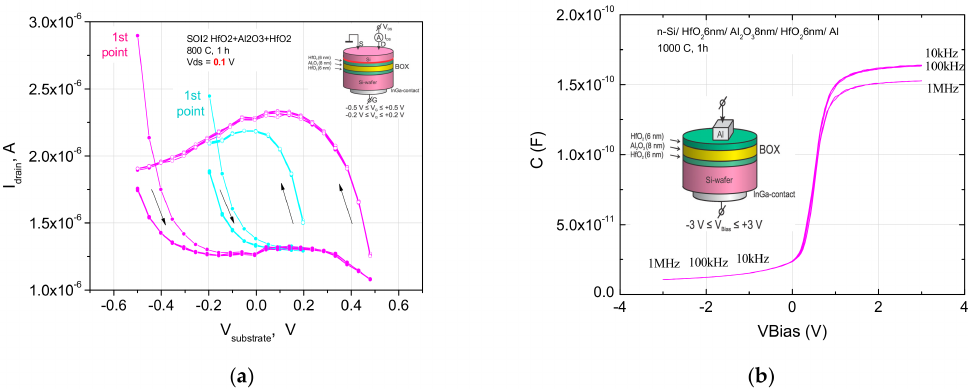
Figure 5. ( a ) Hysteresis behavior of the electron current in the transfer characteristics of n-SIS pseudo-MOSFETs with the 500 nm n-Si/20 nm HfO 2 6 nm/Al 2 O 3 8 nm/HfO 2 6 nm/n-Si substrate on the mesa structures with tungsten needle-shaped contacts (see inset) after the FA at 800 ◦ C for 1 h. Constant sweep rate 50 V/s in the two ranges of V g = − 0.2 + 0.2 V (cyan) and V g = − 0.5 + 0.5 V (magenta) is set for measurements with the starting (1st) point at V g = − 0.2 or − 0.8 V during multicycle measurements. The gate voltage V g is applied to the n-Si substrate; ( b ) C-V plots of the MIS structure with high-k insulator stack HfO2/Al2O3/HfO2 after the FA at 1000 ◦ C for 1 h and top Si layer etching. In the inset are the measurement scheme and the n-type MIS structure